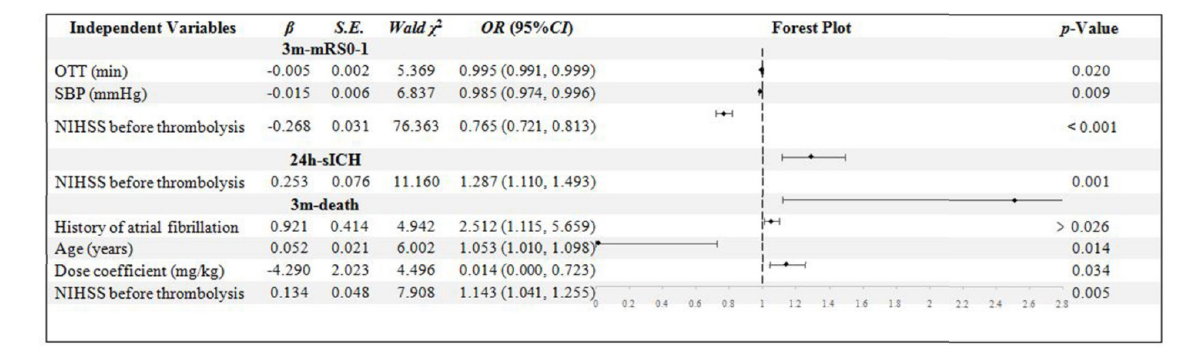
FIGURE2 Binary logistic regression analysis in NIHSS score < 16 group. OTT, onset to thrombolysis time; SBP, systolic blood pressure; NIHSS, National Institute of Health stroke scale; mRS, modified Rankin scale; sICH, symptomatic intracranial hemorrhage.